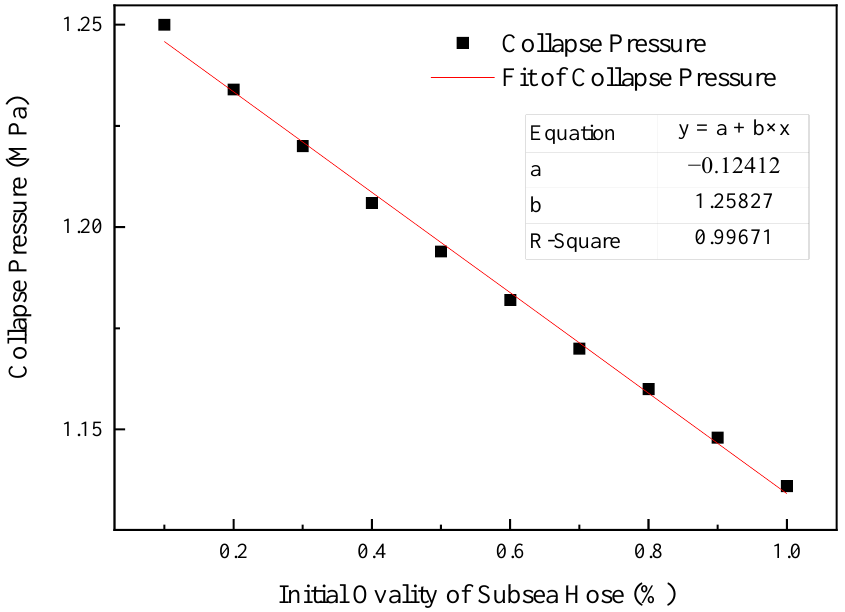
Figure 11. Collapse pressure corresponding to various initial ovality of hose.